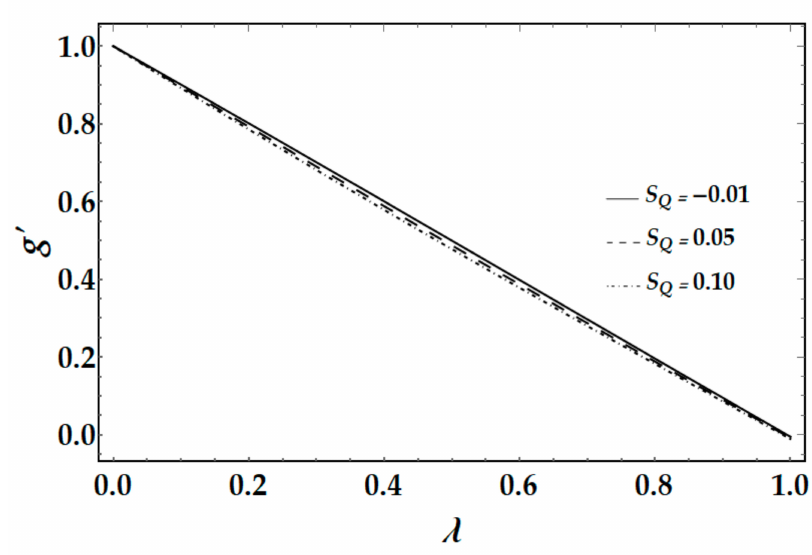
Figure 4. Implications of S Q on velocity distribution (tangential) g (cid:48) ( λ ) .